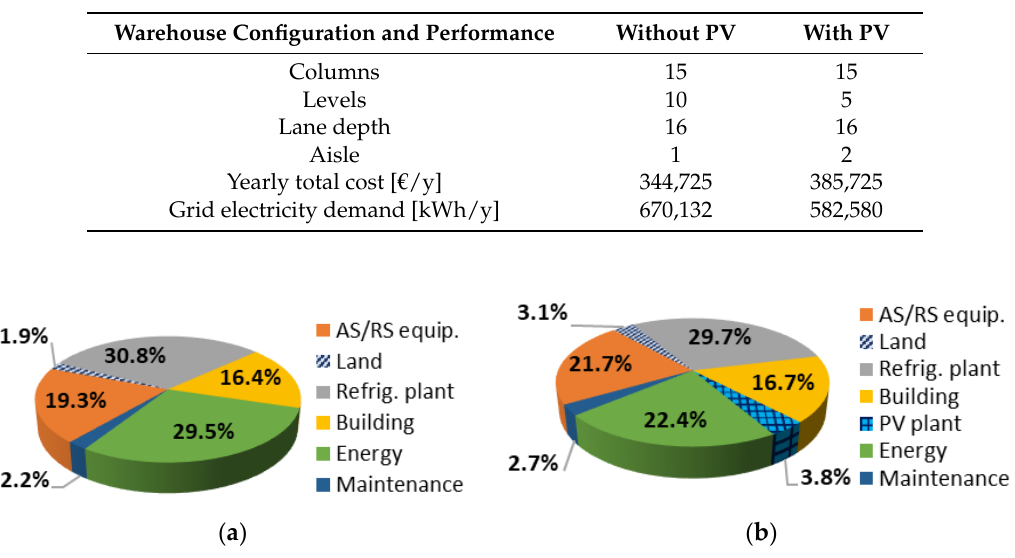
Table 4. Main parameters of the optimal warehouse configuration to minimize grid electricity demand.